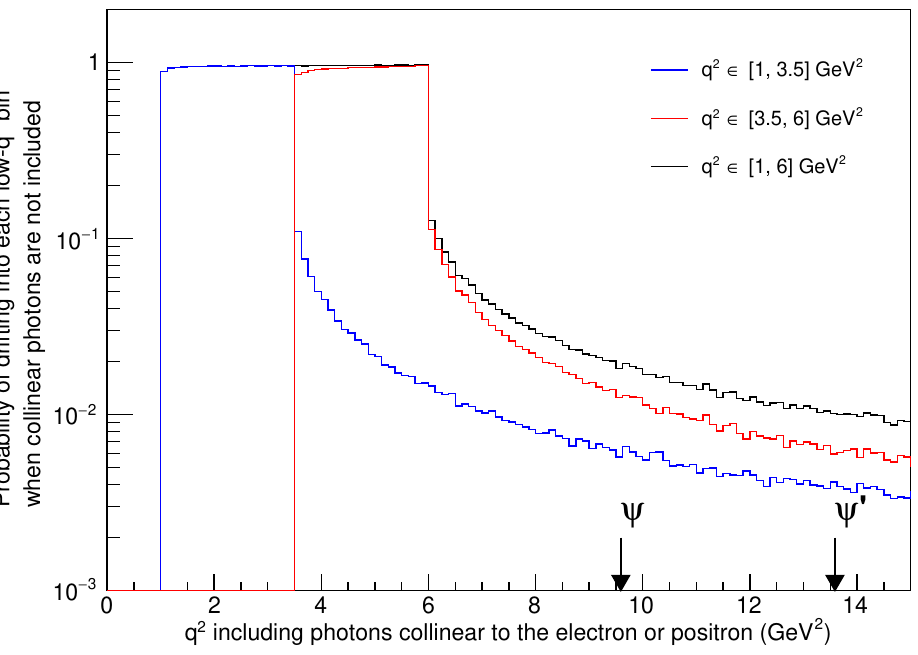
Figure 1 . The probability that a (cid:22) B ! X s ‘ + ‘ (cid:0) event with photons collinear to either outgoing lepton ( (cid:18) < 50mrad and E (cid:13) > 20MeV in the Belle II laboratory frame) will drift into the low- q 2 bin as a result of including only the charged particles in the de(cid:12)nition of q 2 , using events generated in Monte Carlo. The resonances and 0 are marked on the horizontal